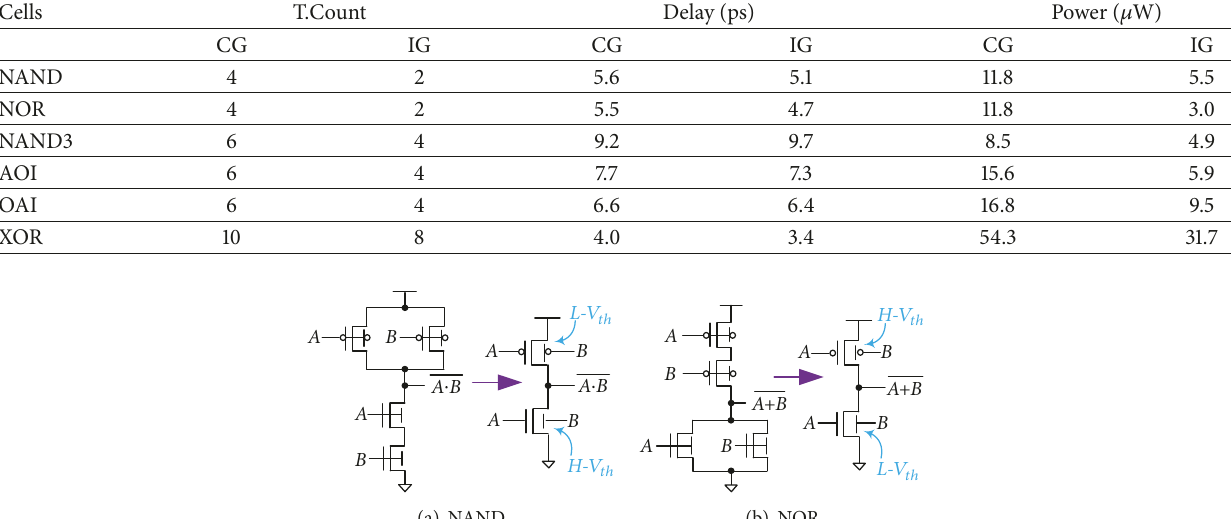
Table 1: Performance comparison of some example cells.